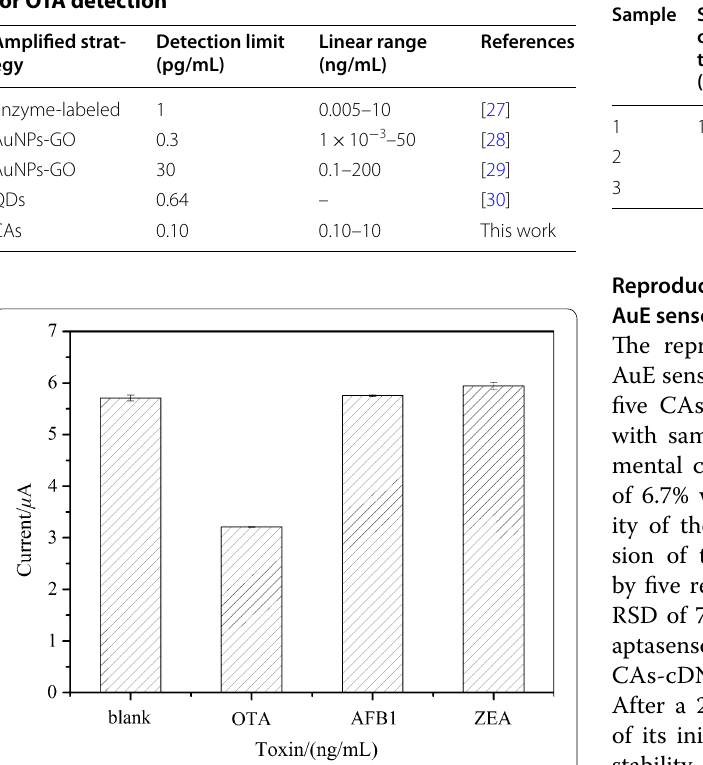
Fig. 7 The specificity of the developed aptasensor towards OTA